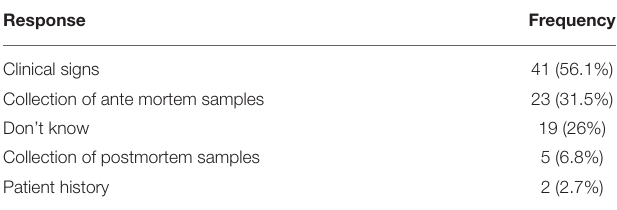
TABLE 3 | Response on how to confirm a case of human